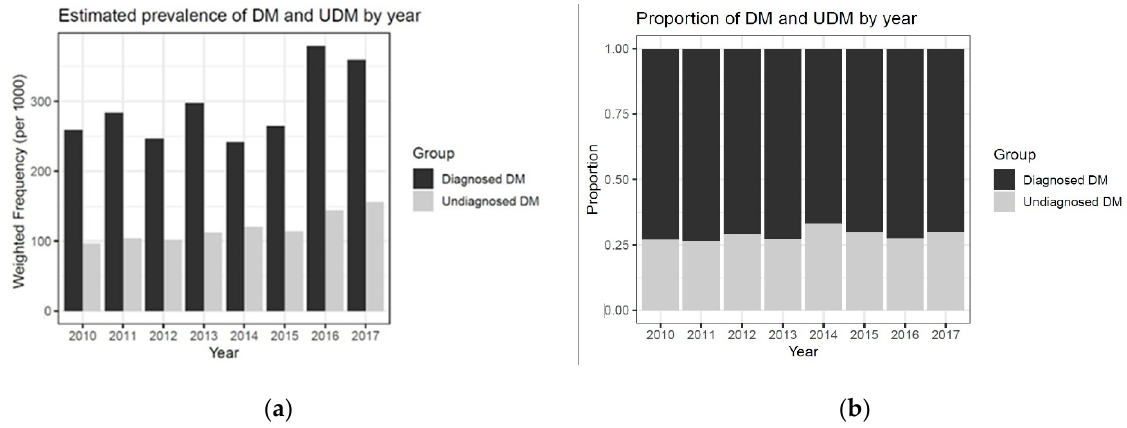
Figure 3. ( a ) Estimated prevalence of diagnosed and undiagnosed diabetes mellitus by year; ( b ) Proportions of patients with diagnosed and undiagnosed diabetes mellitus among all patients.